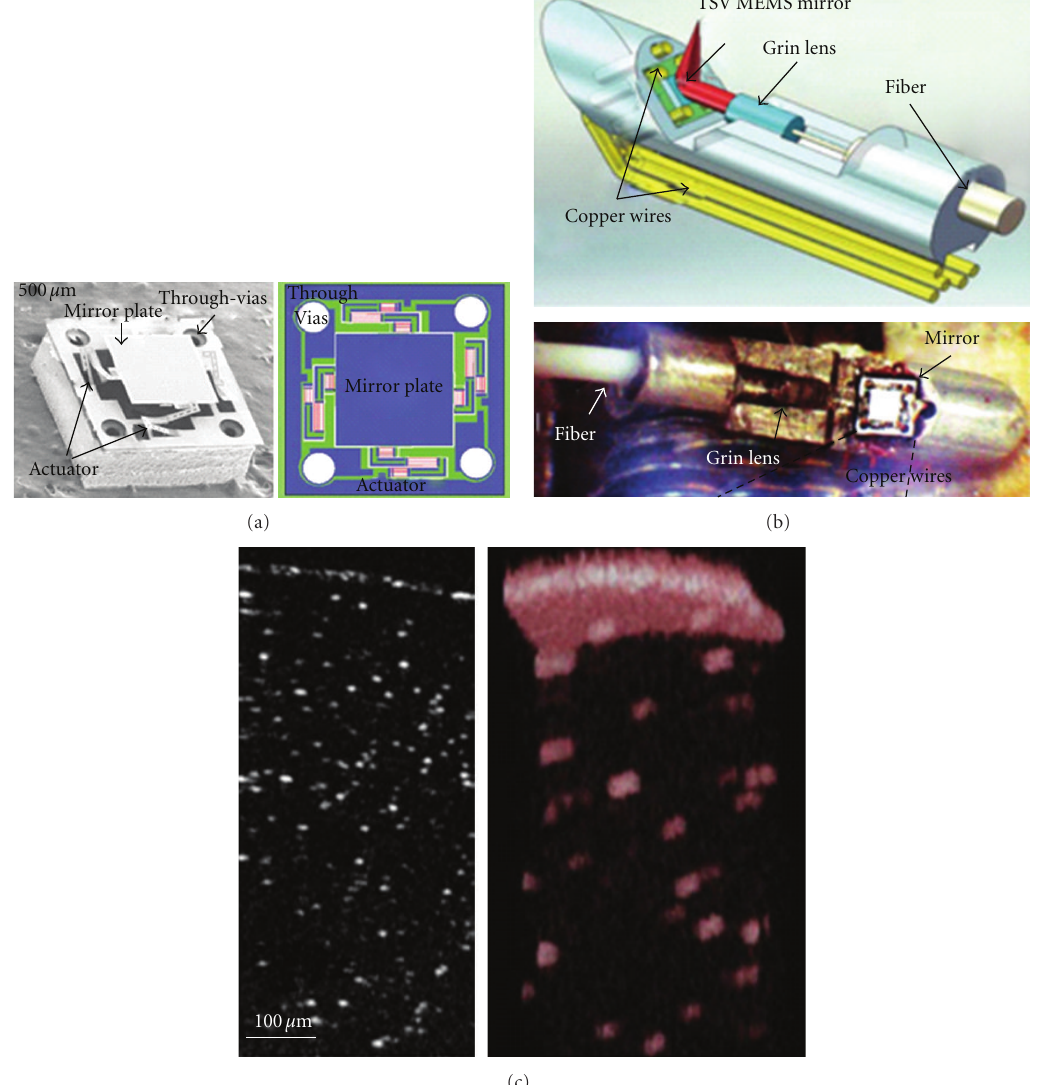
Figure 11: Electrothermal MEMS OCT reported by Liu et al. (a) SEM and schematic of through vias electrothermal MEMS mirror, (b) 2.6mm probe 3D model and assembled probe, and (c) 2D and 3D OCT image of microsphere embedded in PDMS. Reprint permission granted by